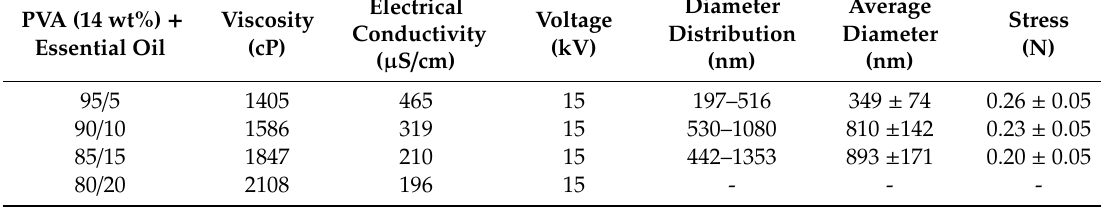
Table 2. Physical properties of PVA / Eucalyptus globules oil (EGO) solutions and diameter distribution of PVA / EGO nanofibrous membranes.